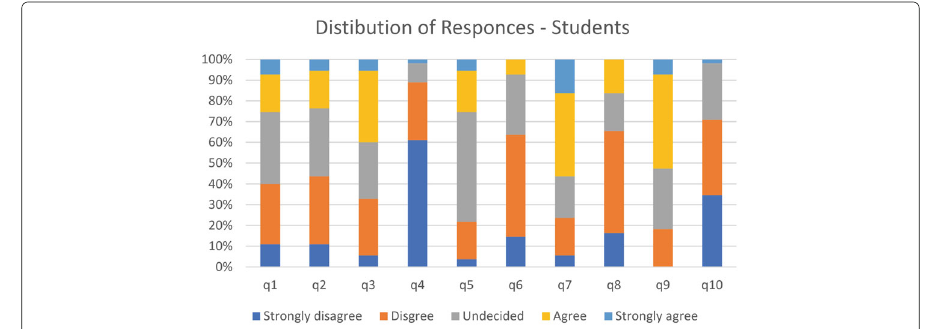
Fig. 9 Distribution of responses from the